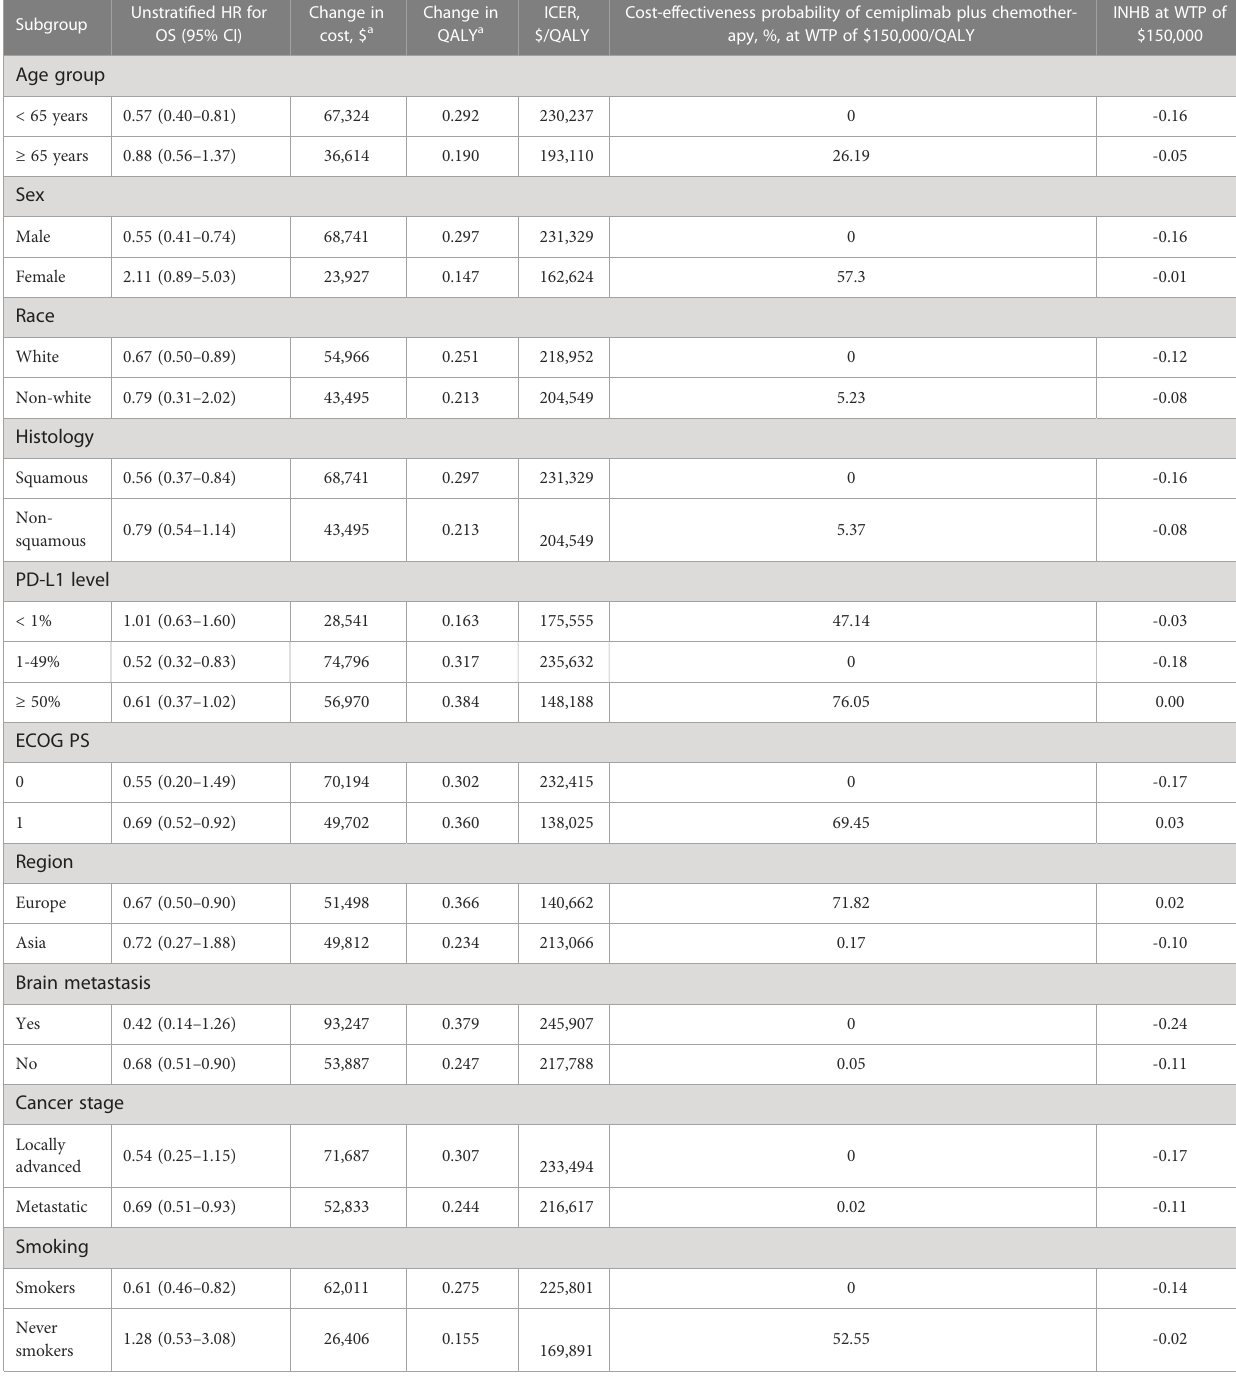
TABLE 3 Summary of subgroup analysis obtained by varying the hazard ratios (HRs) for overall